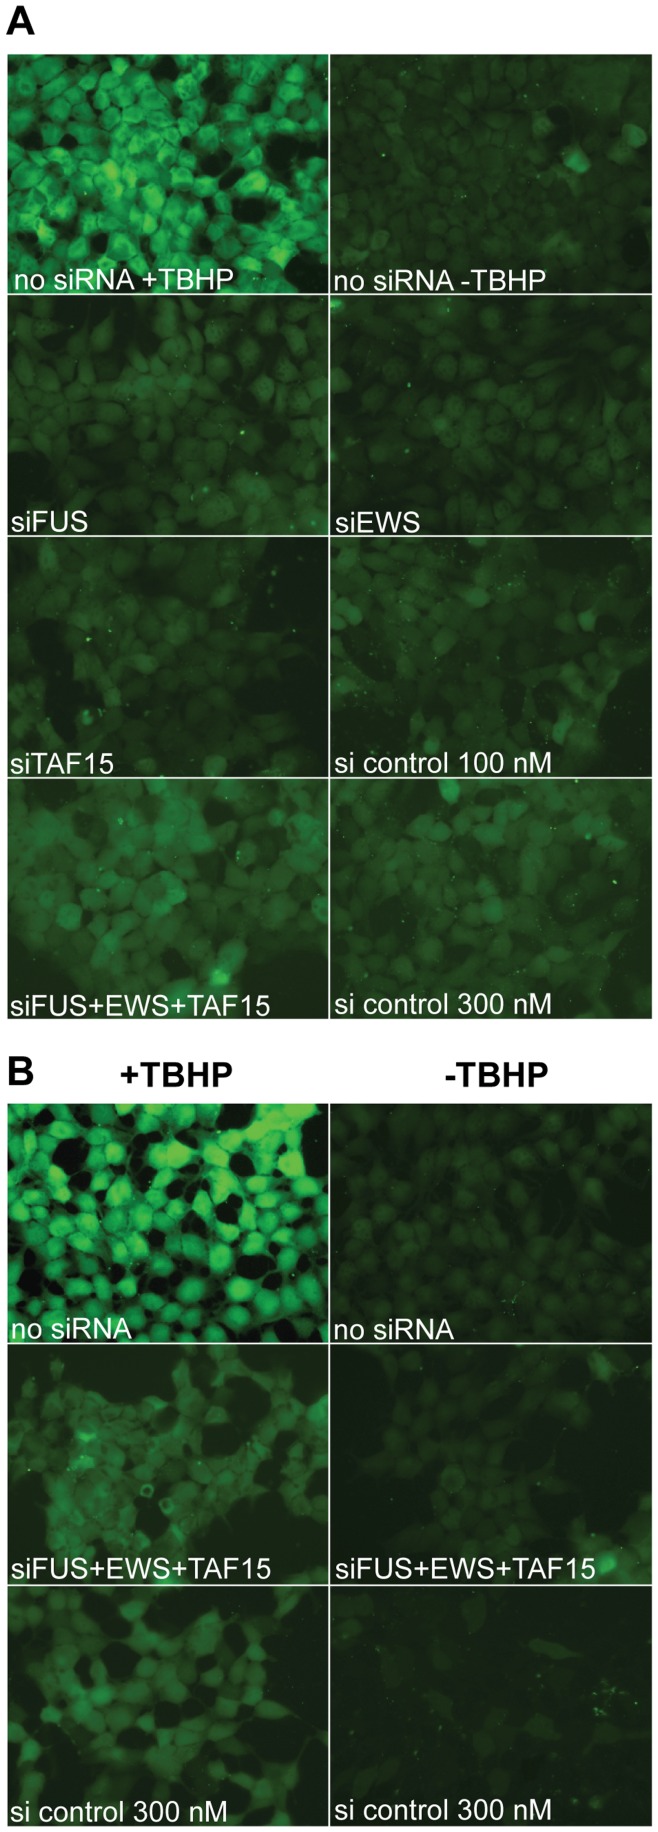
FET-protein reduction is not affecting ROS.(A) HEK293 cells were transfected with siRNAs targeted against the FUS, EWS, or TAF15 mRNAs, or with an unspecific siRNA as control. Cells were also transfected with a combination of all three FET siRNAs (300 nM total concentration) or unspecific siRNA at concentration of 300 nM (lower panel). The level of ROS in the cells was measured and evaluated by microscopy. Untransfected cells treated with TBHP is a positive control of oxidative stress (upper panel left), and untransfected cells without TBHP treatment is a negative control of oxidative stress (upper panel right). (B) HEK293 cells were transfected with a combination of all three FET siRNAs (300 nM total) or with an unspecific siRNA as control. Cells were subsequently treated with TBHP to induce oxidative stress (left columns), and the level of ROS was measured and evaluated by microscopy and compared to unstressed cells (right columns). Untransfected cells treated with TBHP is a positive control of oxidative stress (upper panel left), and untransfected cells without TBHP treatment is a negative control of oxidative stress (upper panel right).